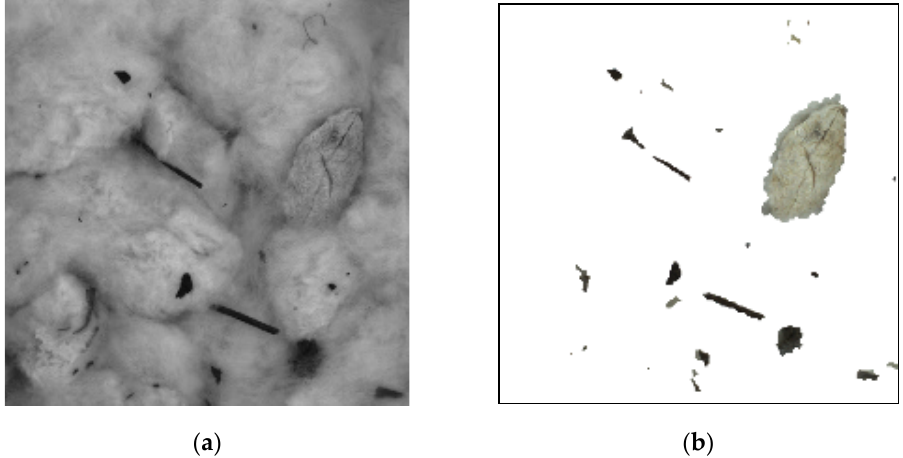
Figure 5. Segmentation results of impurity in machine-picked seed cotton. ( a ) The original image; ( b ) impurities after segmentation.